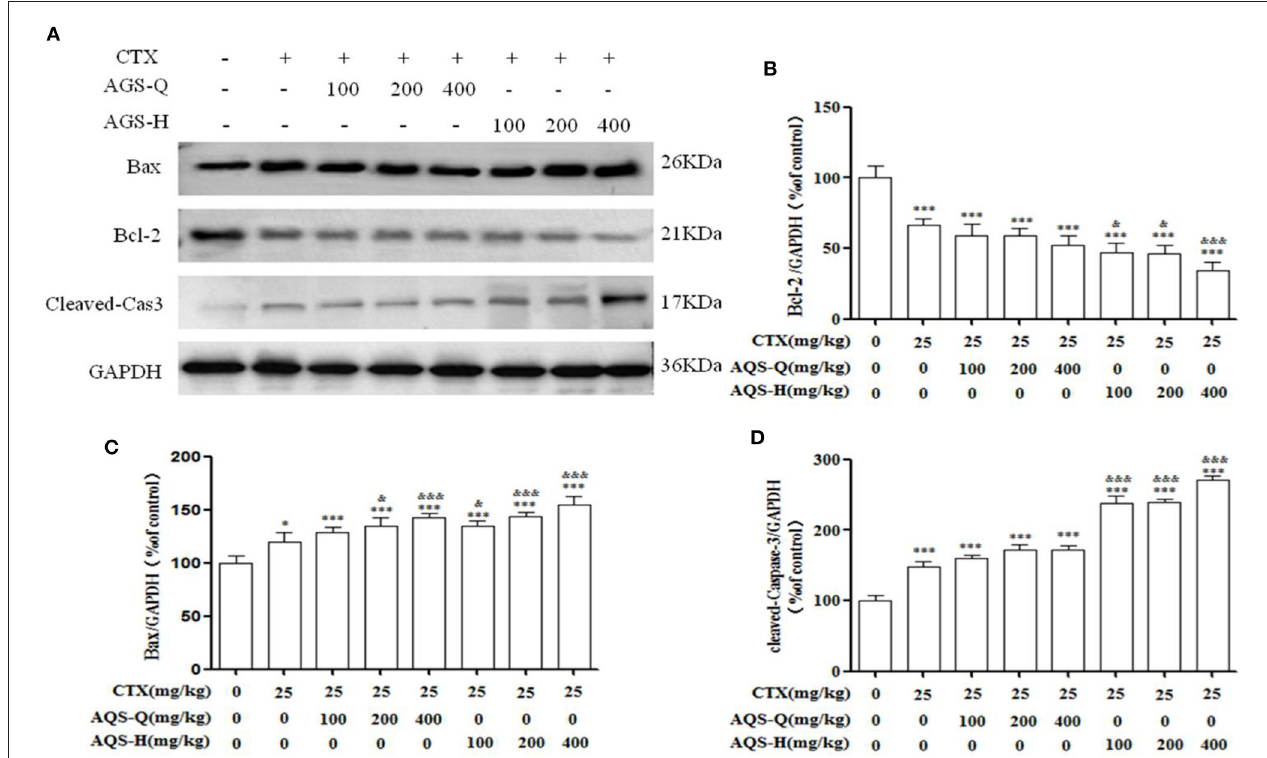
FIGURE 7 | Effects of AGS synergistic CTX on Bcl-2, Bax and cleaved-Caspase-3 in S180 tumor-bearing mice ( n = 8). (A) The protein expression levels of Bcl-2, Bax and cleaved-Caspase-3 were detected by Western blotting. (B) The relative Bcl-2 expression level. (C) The relative Bax expression level. (D) The relative cleaved-Caspase-3 expression level. Values are presented as mean ± SD. vs. model group, * P < 0.05, ** P < 0.01, *** P < 0.001; vs. CTX group, & P < 0.05, && P < 0.01, &&& P < 0.001.